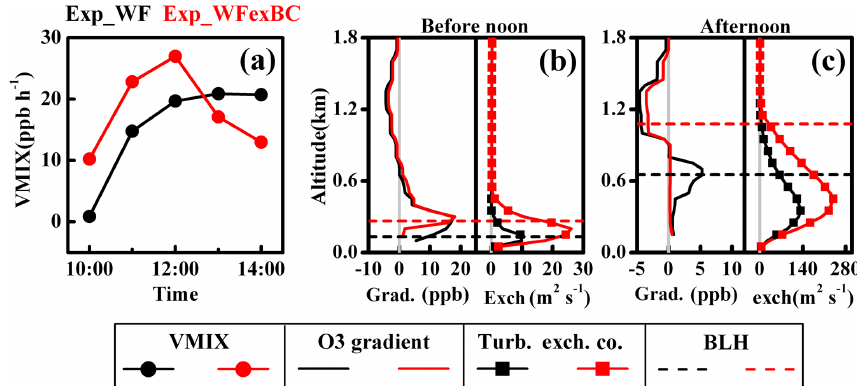
Figure 7. (a) Time series of vertical mixing contribution (line with circles; unit: ppbh − 1 ) from 10:00 to 14:00LT and profiles of ozone vertical gradients (solid lines; unit: ppb) and turbulence exchange coefficient (line with squares; unit: m 2 s − 1 ) in Exp_WF (black) and Exp_WFexBC (red) before noon (b) and in the afternoon (c) . BL heights (BLH; dashed line; unit: km) of Exp_WF and Exp_WFexBC are denoted in (b) and (c)